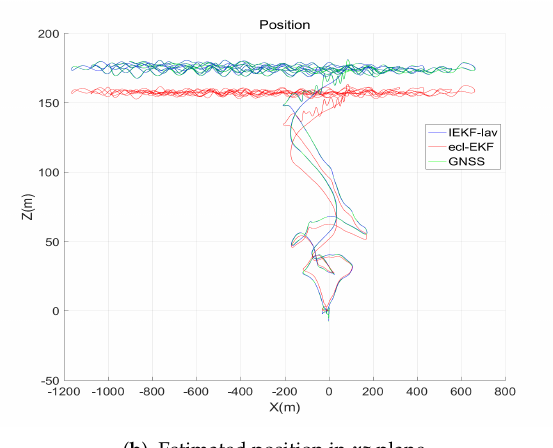
Figure 2. Robot positions estimated by invariant extended Kalman filter (IEKF)-lav and